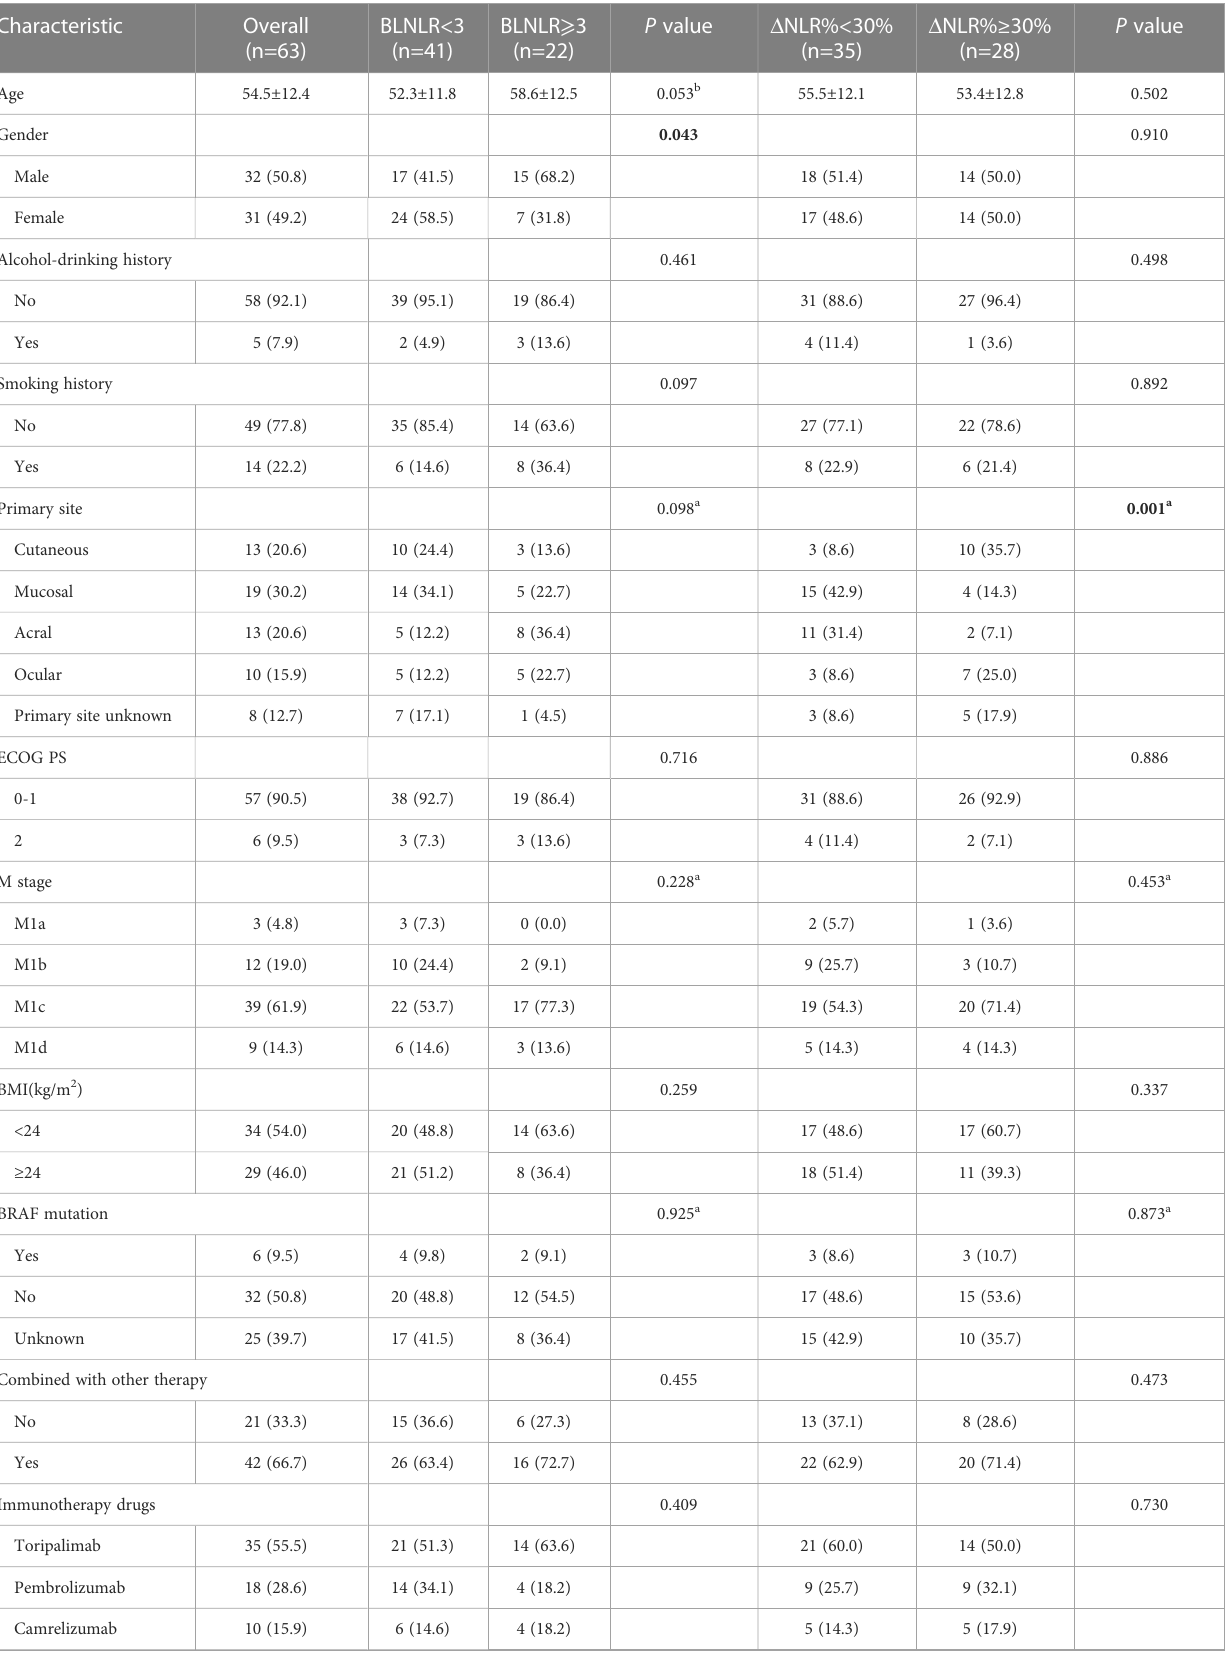
TABLE 1 Baseline characteristics of 63 patients with metastatic